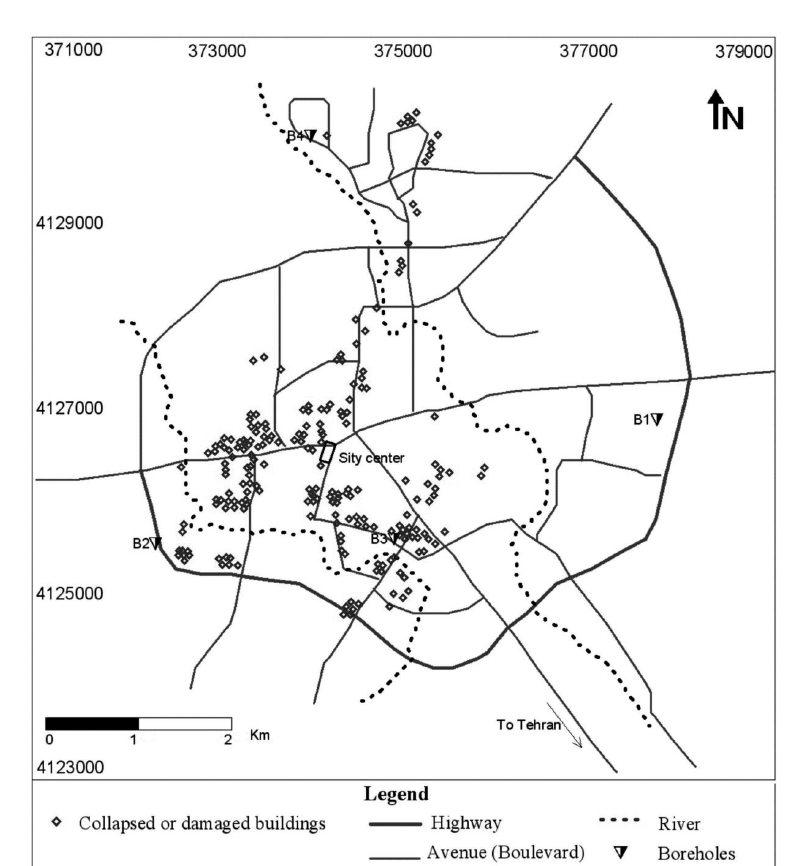
Fig. 2. Location map of destroyed or damaged buildings in Rasht city during 1990 Manjil earthquake (Natural Disaster Prevention Center,